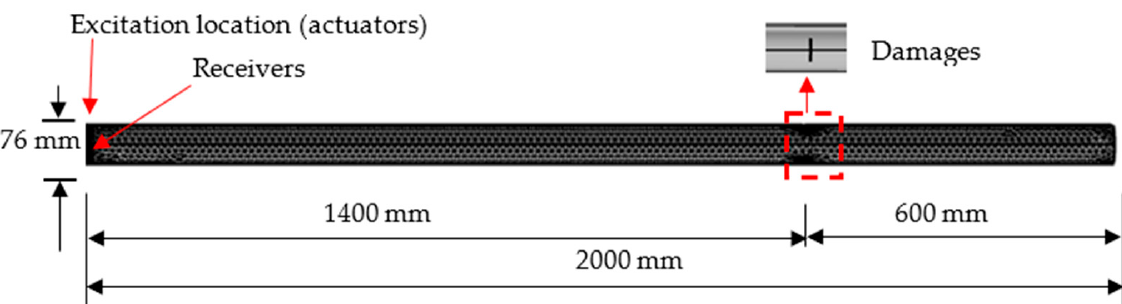
Figure 4. Pipe model from the literature.